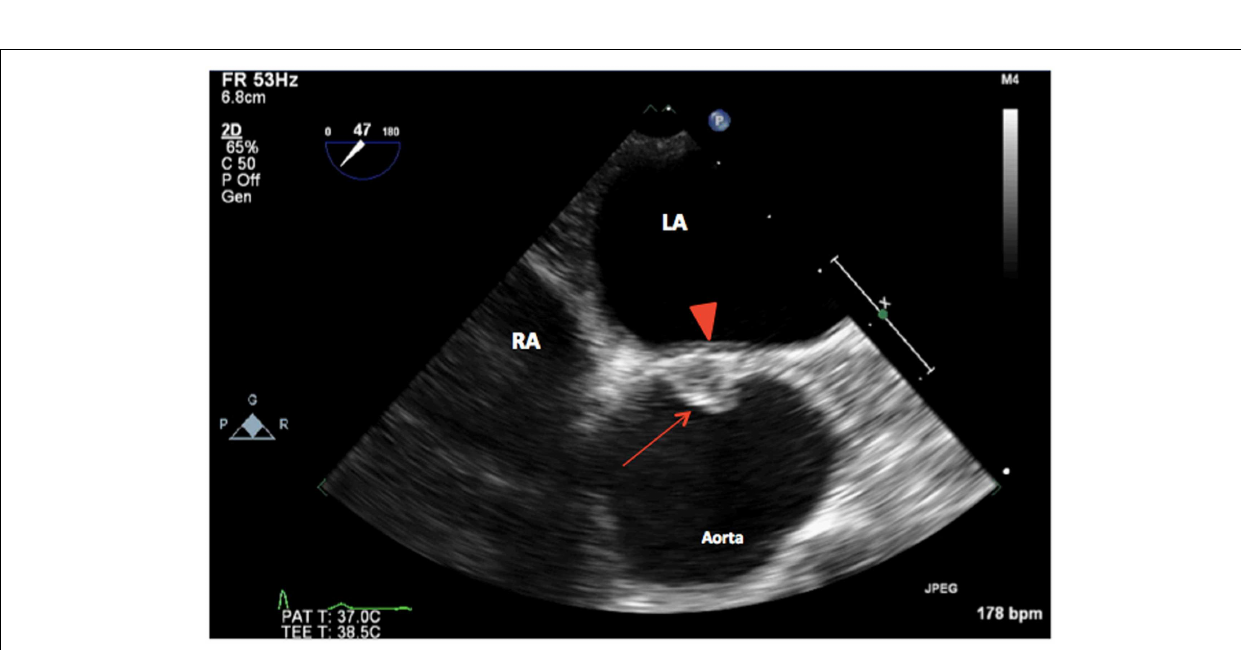
FIGURE 2 | 2DTEE midesophagealAV short-axis view showing a unicuspid aortic valve (arrow) with a single posterior commissure in diastole (arrowhead). LA, left atrium; RA, right